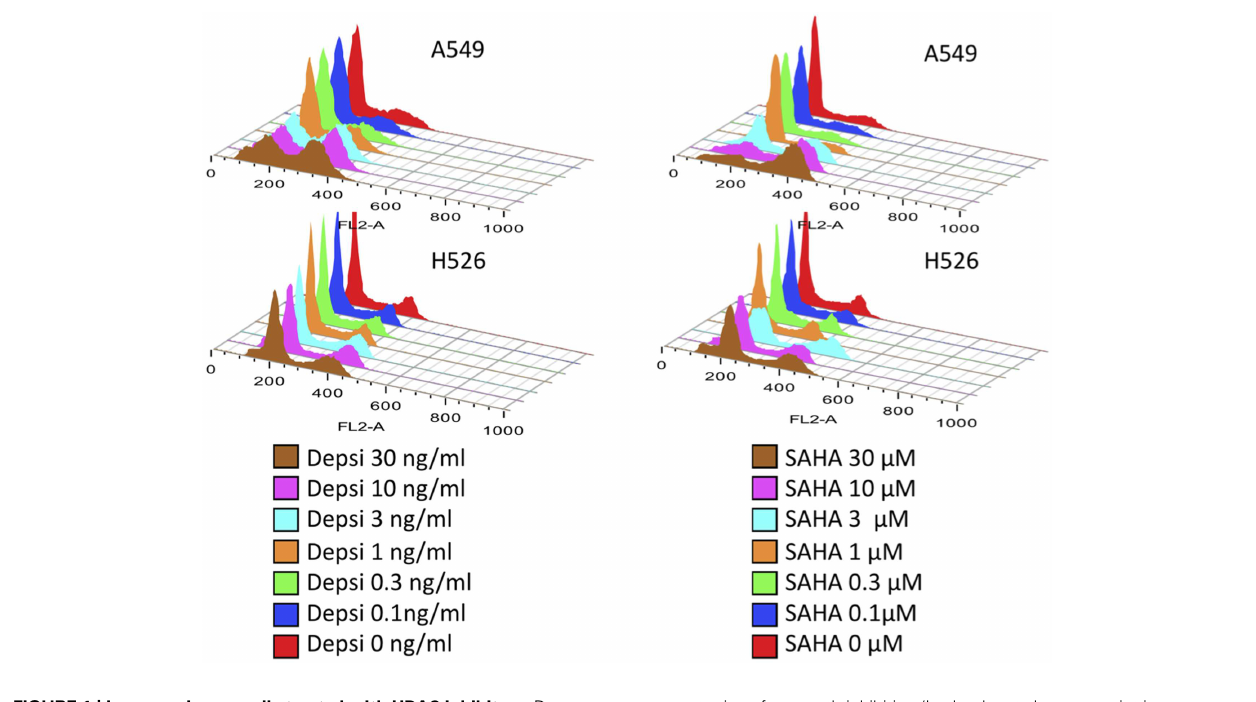
FIGURE 1 | Lung carcinoma cells treated with HDAC inhibitors . Dose response studies of cell cycle following 24h treatment with either romidepsin (DEPSI) or vorinostat (SAHA) are show in the histograms. Concentrations are shown in the legend and represent equipotent